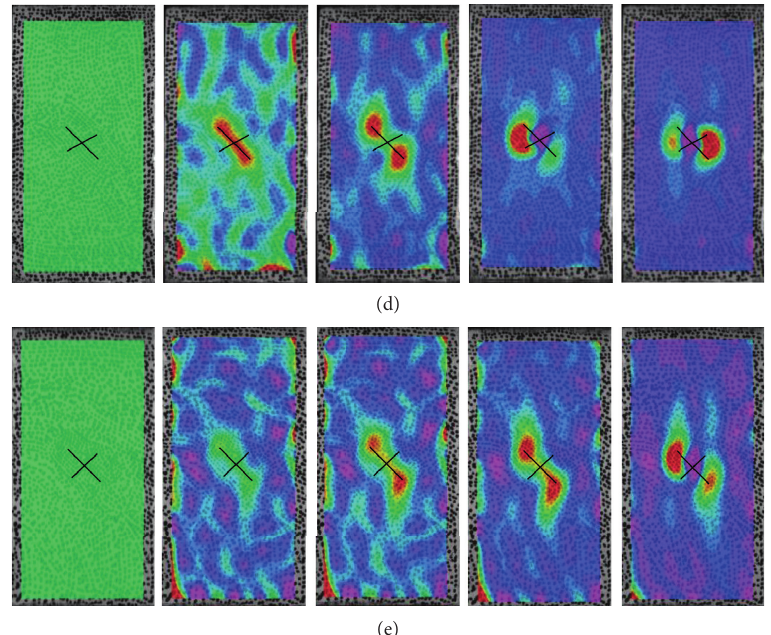
Figure 7: Surface maximum principal strain characteristics of the samples with different cross cracks: (a) α � 45 ° , β � 0 ° ; (b) α � 45 ° , β � 30 °